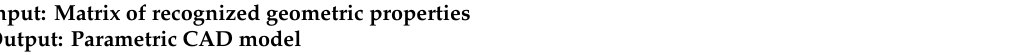
Table 2. Pseudocode of geometry import algorithm to SOLIDWORKS software.